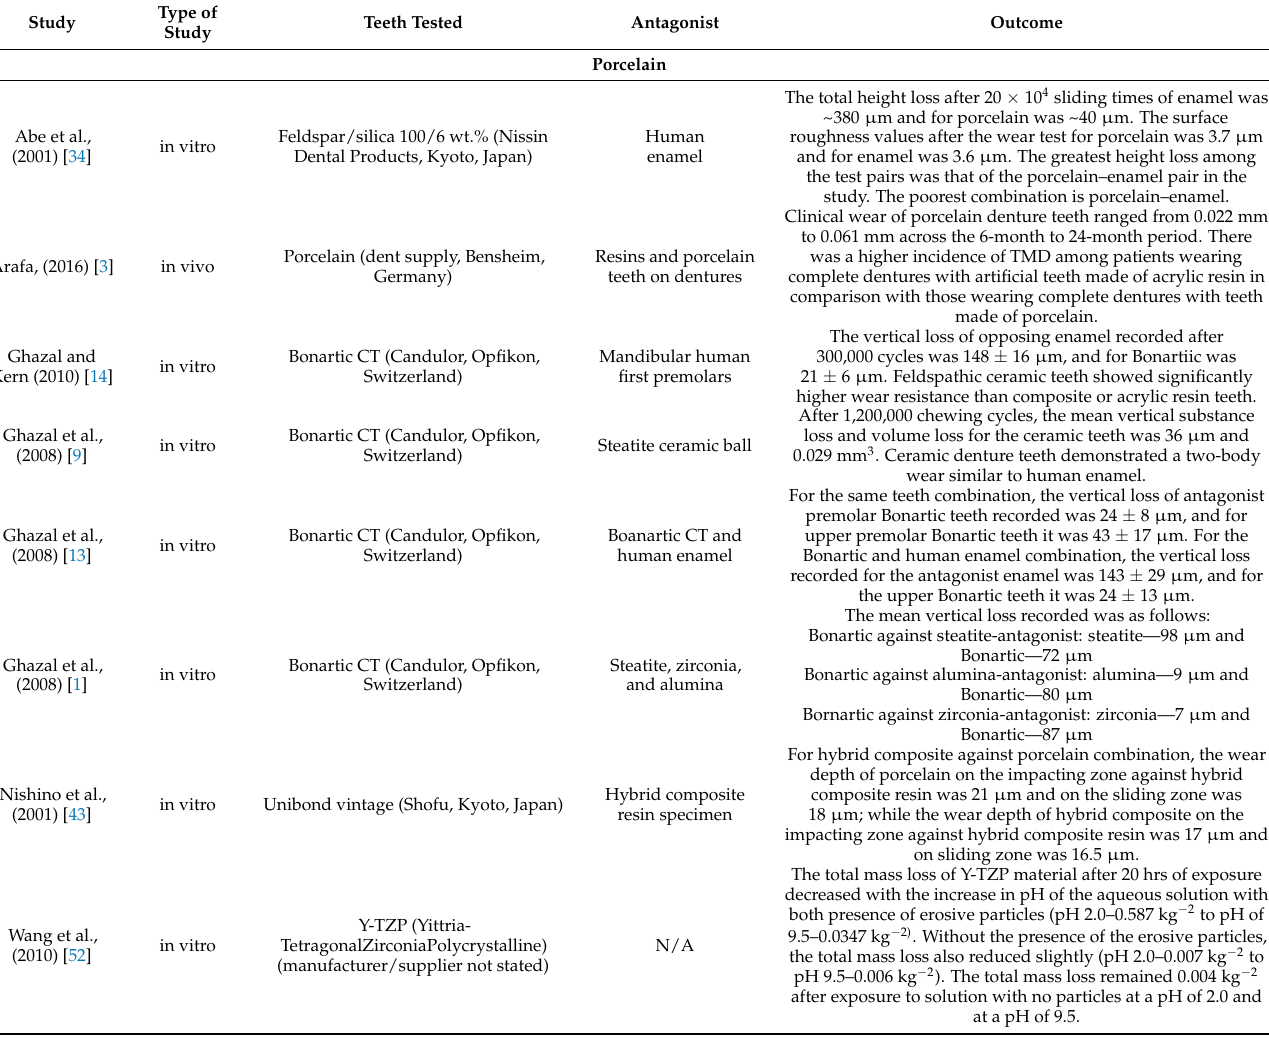
Table 7. Main findings of the selected studies on denture teeth wear (porcelain and